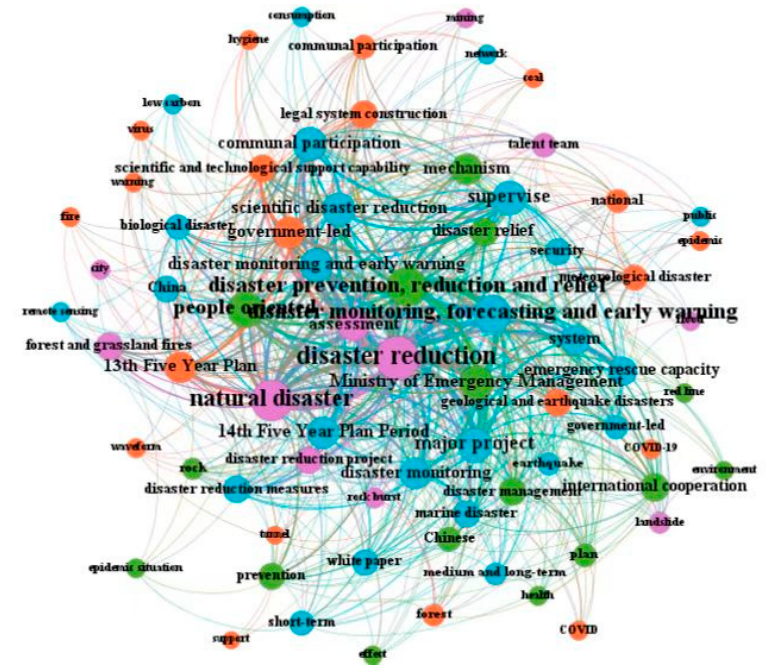
Figure 7. The keyword co-occurrence map of China’s dynamic disaster monitoring and early warning national policy in the rapid development stage